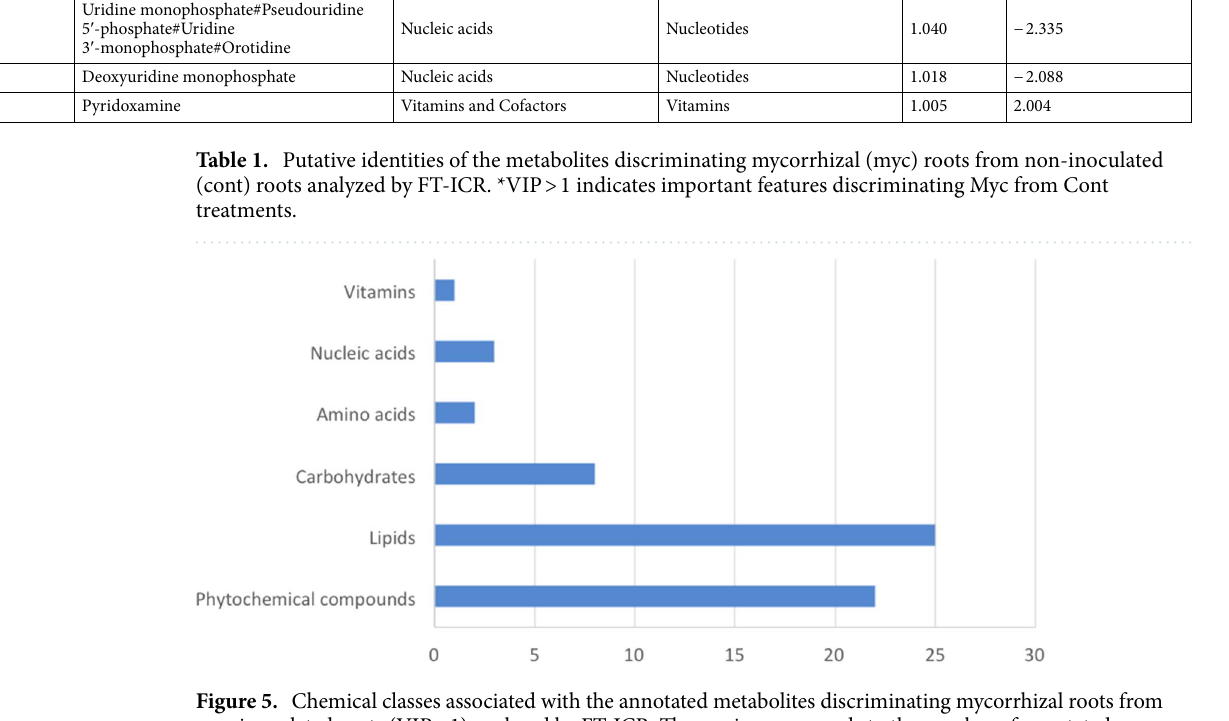
Figure 5. Chemical classes associated with the annotated metabolites discriminating mycorrhizal roots from non-inoculated roots (VIP > 1) analysed by FT-ICR. The x axis corresponds to the number of annotated masses assigned to each class